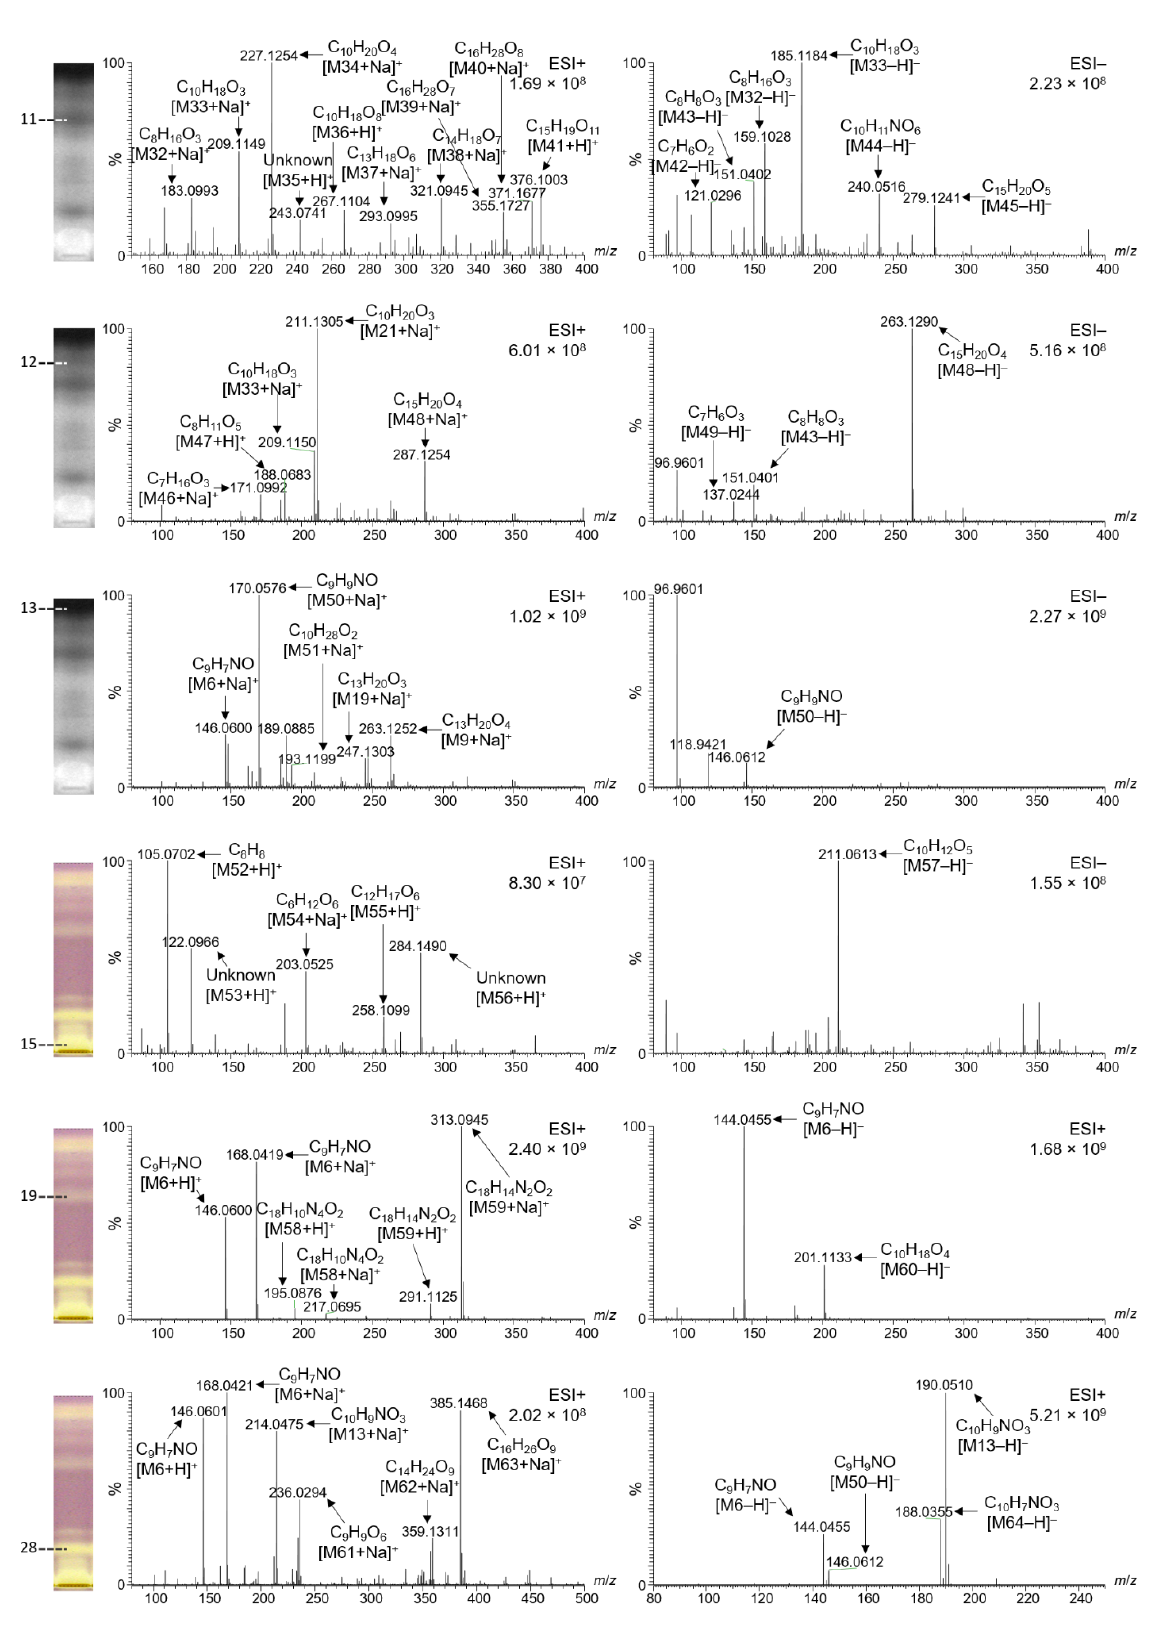
Figure 5. HPTLC–HESI–HRMS spectra in the positive and negative ionization mode of prominent bioactive zones of Coffea arabica honey detected via the Aliivibrio fischeri bioassay or DPPH• radical scavenging assay (for orientation, zones are marked as in Figure 3).